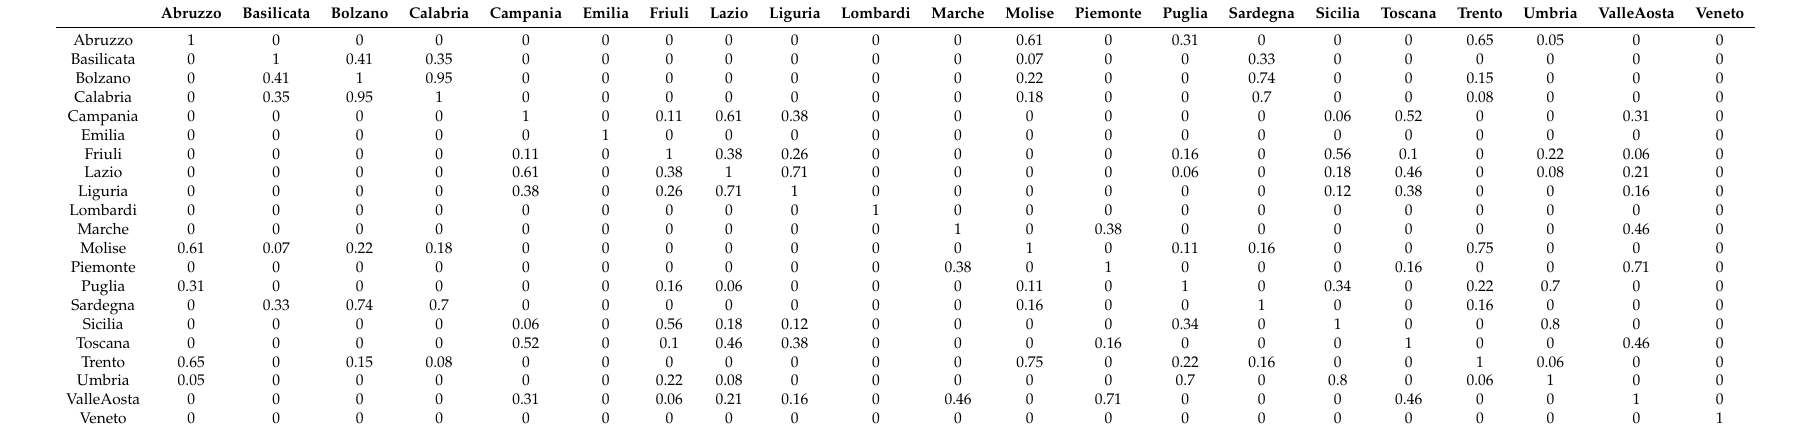
Table A51. Similarity values of Total Cases network in the second week.